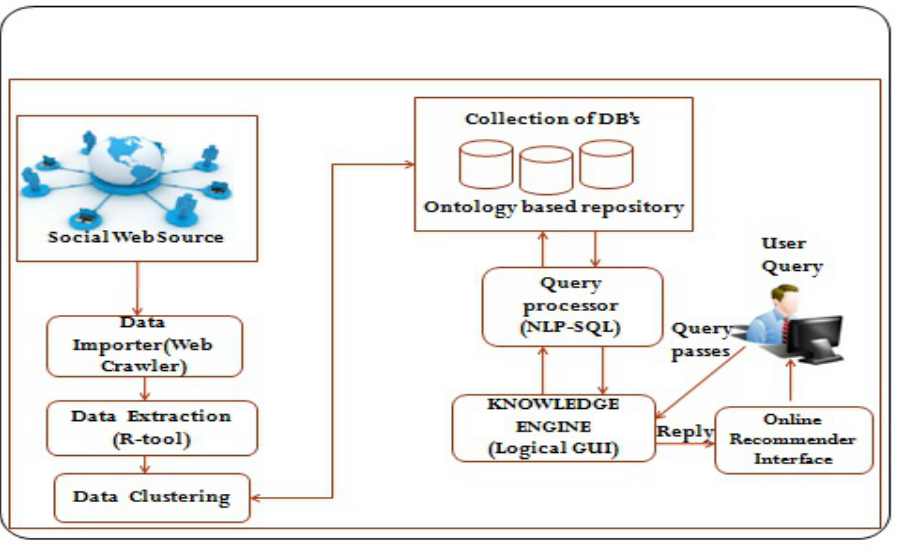
Figure 1 . Architecture diagram for